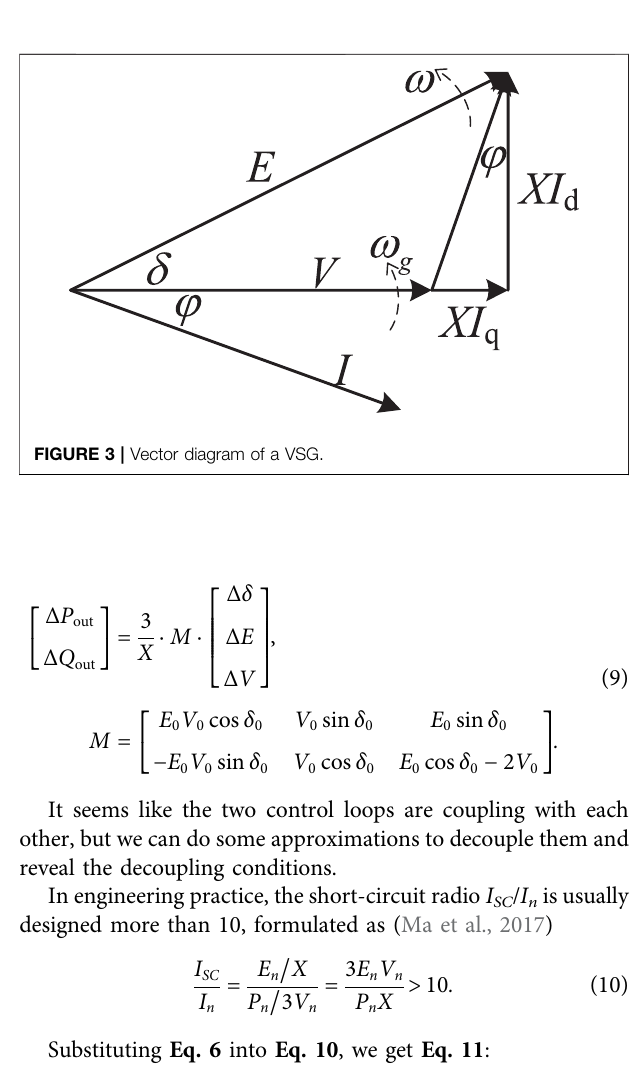
Figure 3 is the vector diagram of Figure 1 (ignore R ). Figure 3 reveals the role of δ , formulated as Eqs 7 – 9 .